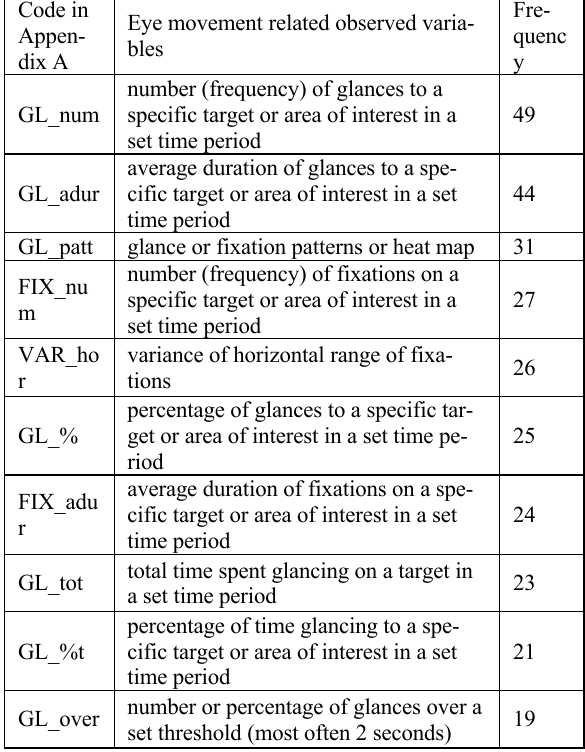
Table 5. Frequency of used observed eye movement related